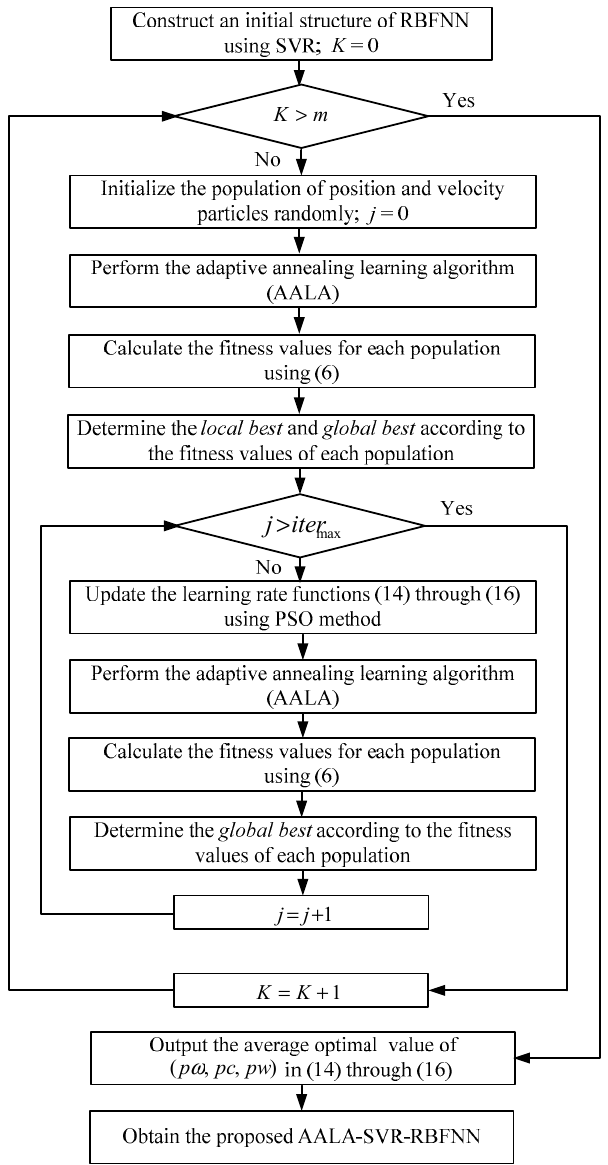
Figure 2. The flowchart of AALA-SVR-RBFNN.